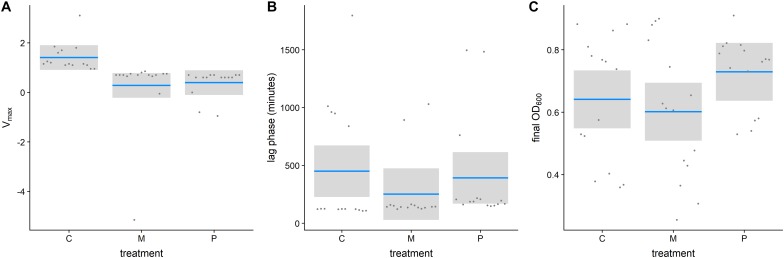
Growth parameters of evolved AMP-resistant Staphylococcus aureus in relation to treatment [Vmax (A), lag phase (B), final OD (C)]. (Con: unselected control, M: melittin-selected strains, P: pexiganan-selected strains, blue line: mean, gray box: 95% confidence intervals).